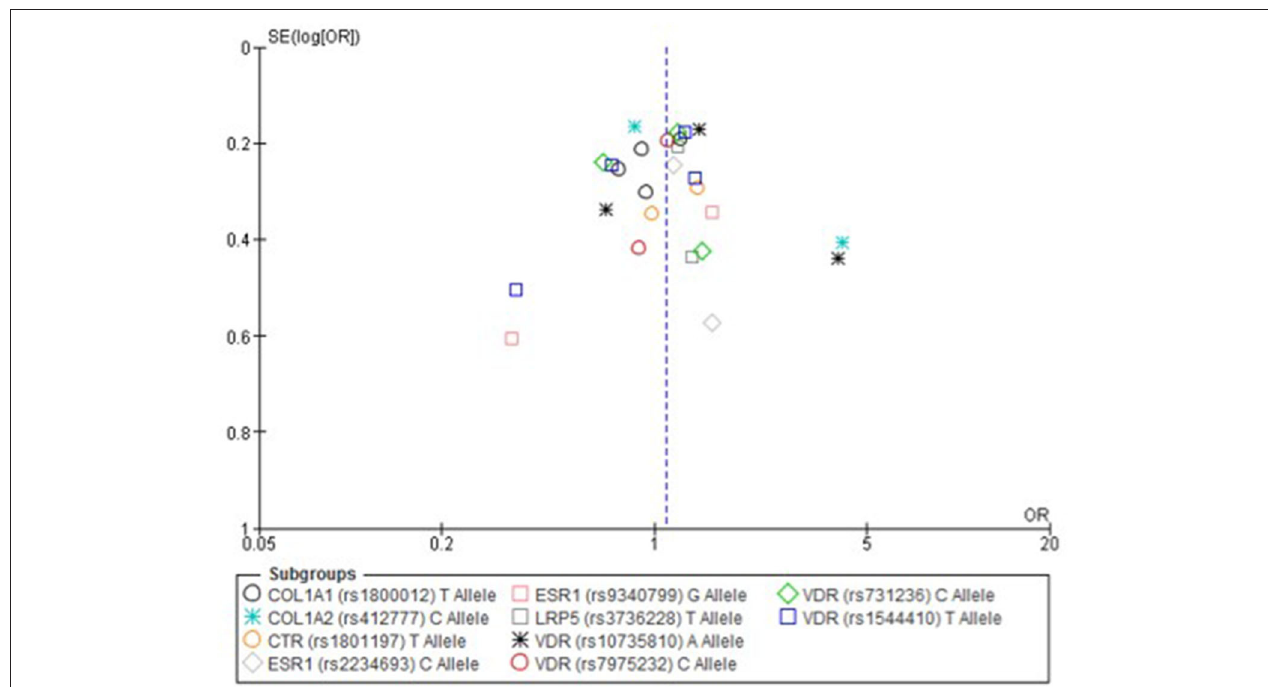
FIGURE 3 | Funnel plot of single nucleotide polymorphisms replicated in studies investigating genetic association with fracture risk in physically active participants using the allele contrast model.